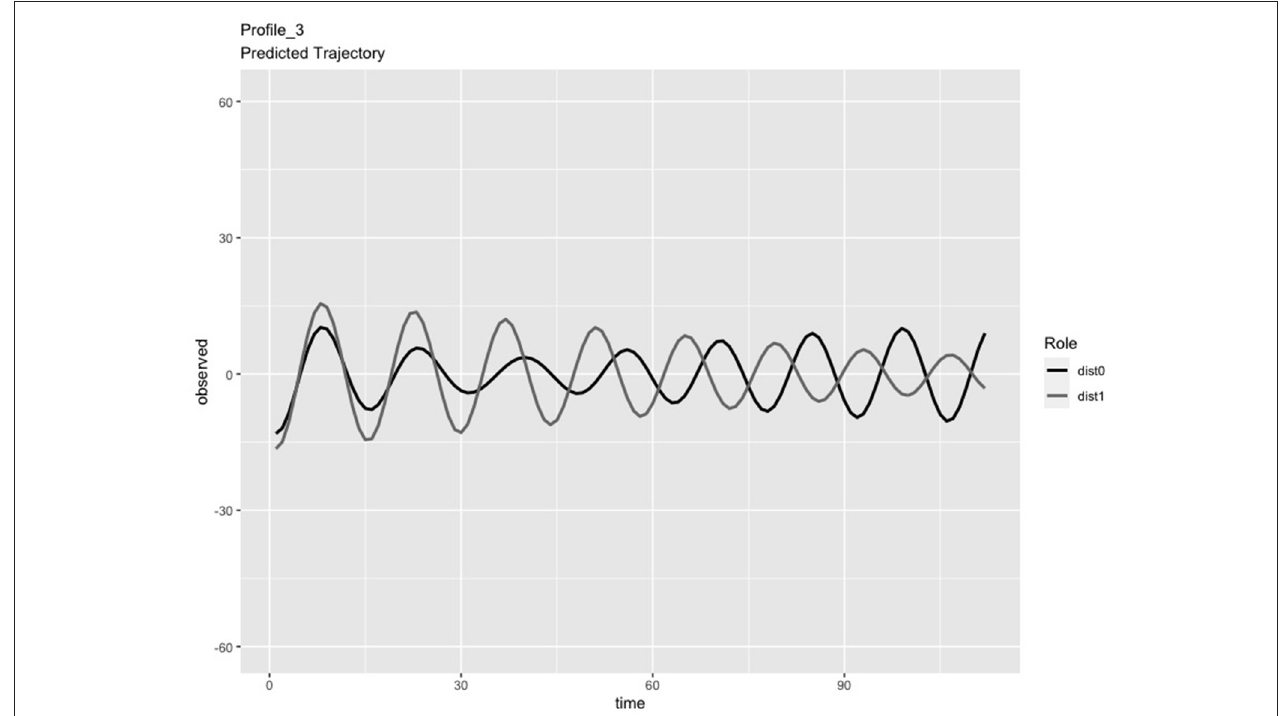
FIGURE 3 | Profile 3, labeled as the Complex Profile, characterized by a fast frequency, shifting to anti-phase pattern ( n = 21 dyads).